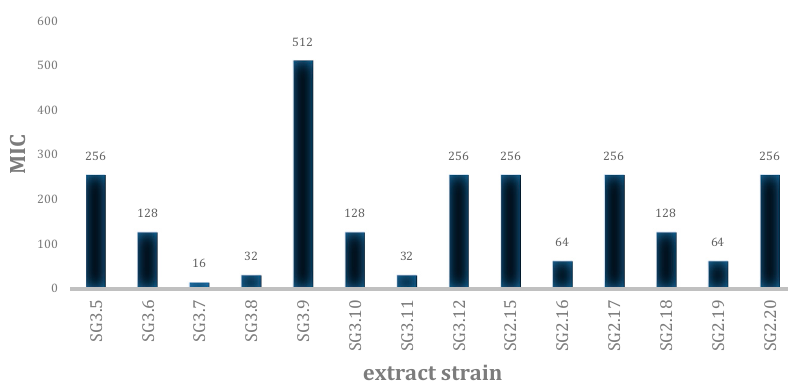
Figure 1. Minimal Inhibitory Concentration (MIC) of the extract strains isolated from S. guyanensis latex on methicillin-resistant Staphylococcus aureus (MRSA).